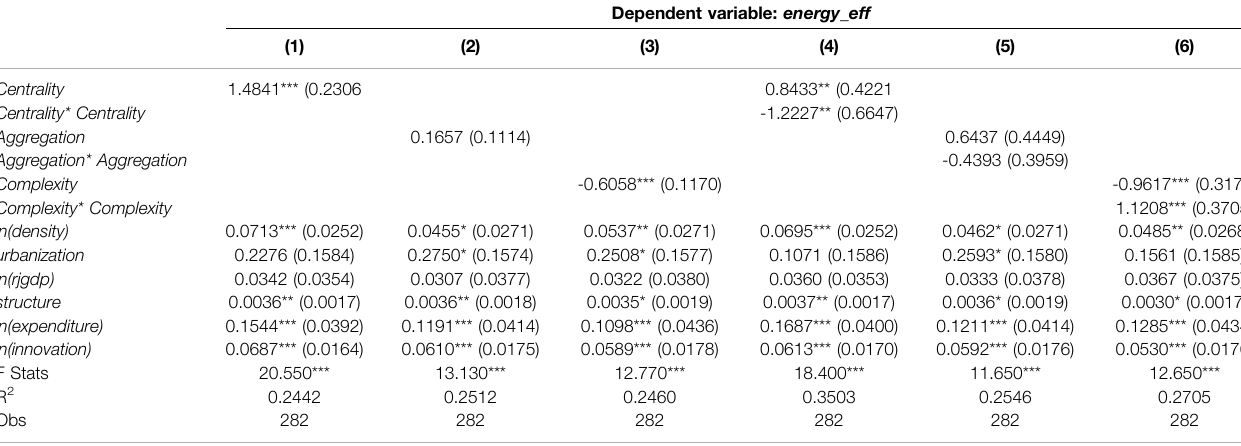
TABLE 2 | Baseline regression estimation